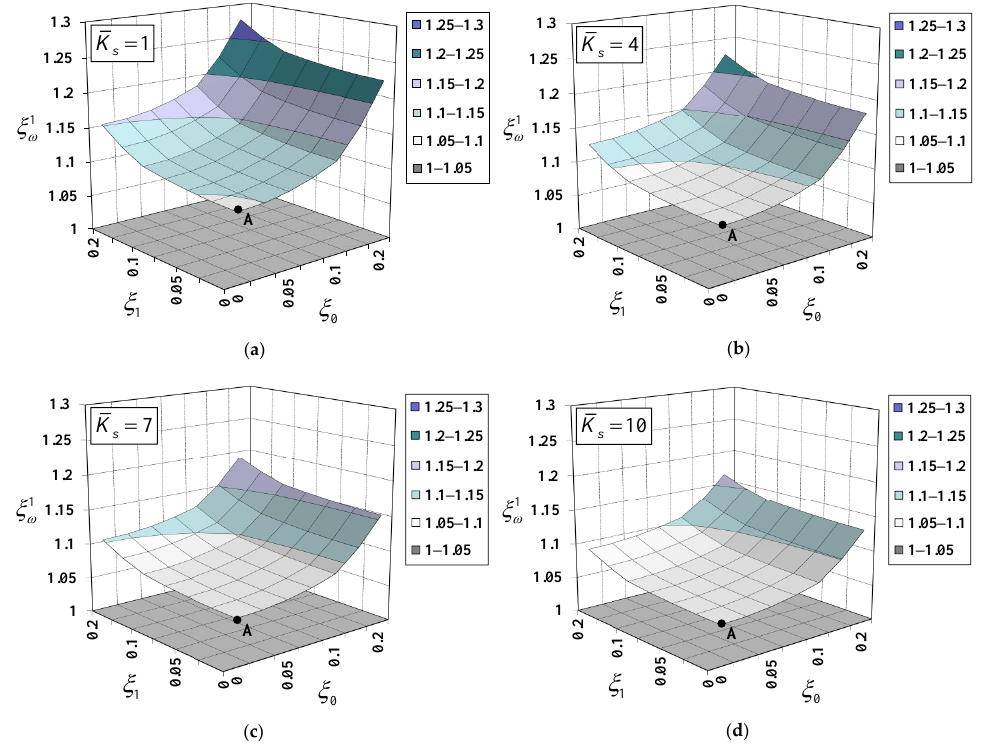
Figure 9. Variation of normalized natural frequency for the first vibration mode with material length-scale parameters for various elastic substrate stiffnesses: ( a ) K s = 1, ( b ) K s = 4, ( c ) K s = 7, and K = . 10 s ( d ) K s = 6.2.2. Effect of Surface-Free Energy on Natural Frequencies of SWCNT – Substrate Medium Systems To assess the surface energy effect on the system natural frequency, a clamped – free SWCNT embedded in the substrate medium shown in Figure 10 is employed in this analysis case. The material and geometric properties as well as the surface modulus of the SWCNT follow those employed in the previous analysis case. Two non-dimensional material length-scale parameters, 0